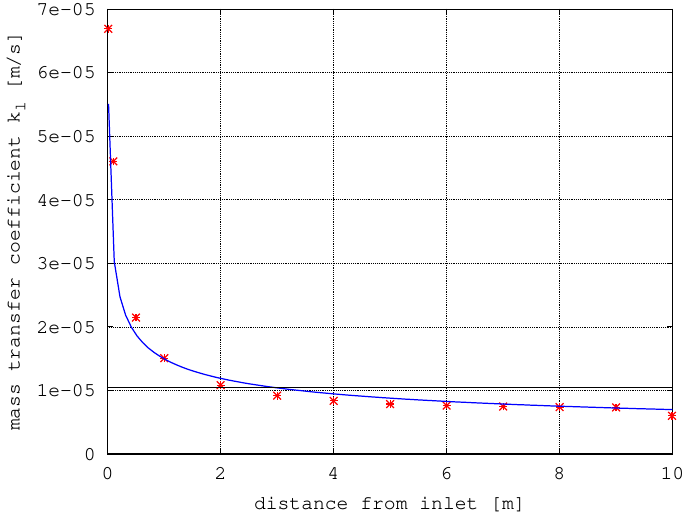
Figure 2. Liquid-side mass transfer coefficient k l dependency on the distance from the inlet evaluated in a separate CFD simulation of moving water thin layer of constant